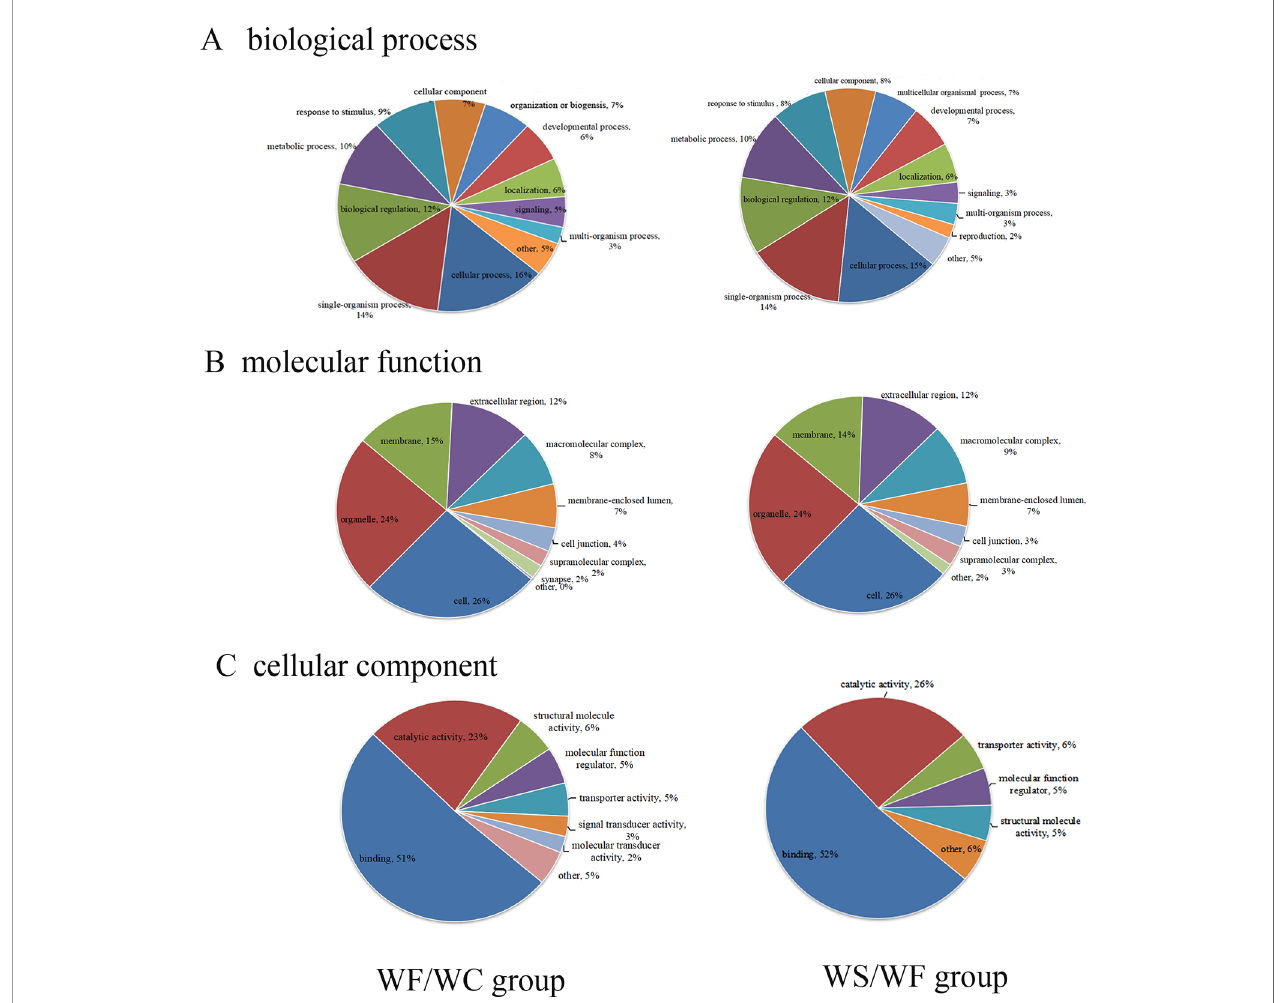
FIGURE 4 | The proportion of differential protein biological process (BP), cell composition (CC), and molecular function (MF) protein species (Left: WF/WC group; Right: WS/WF group). (A) The functions of these two groups were basically the same, mainly involved in cell process, single-cell biological process, biological regulation, molecular metabolism, and stress response; (B) CC analysis revealed the two groups of differential proteins were mainly involved in the cytoplasmic composition, followed by organelle proteins, cell membrane proteins, extracellular matrices, macromolecular complexes, etc; (C) In the MF analysis, the two groups of differential proteins mainly have integration and catalytic